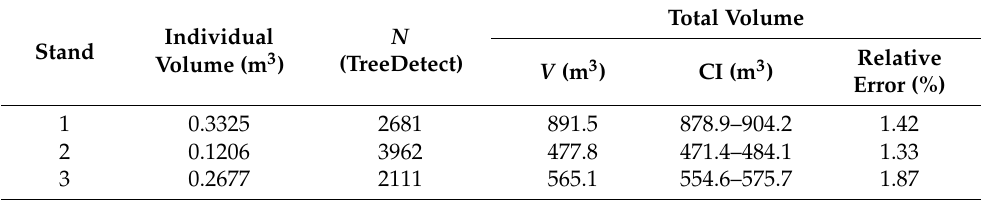
Table 4. Confidence interval and precision of the stand volume based on the individual approach.